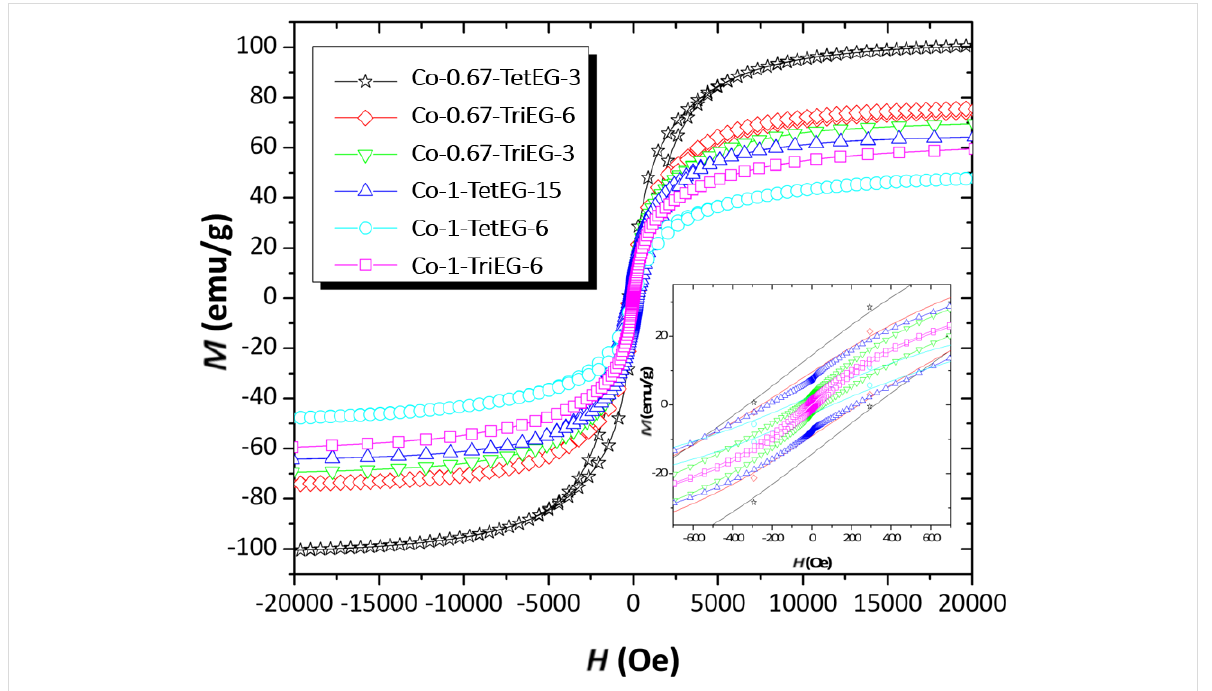
Figure 6: Magnetisation curves of NPs measured at 300 K. Inset: zoom-in of the coercive behavior.